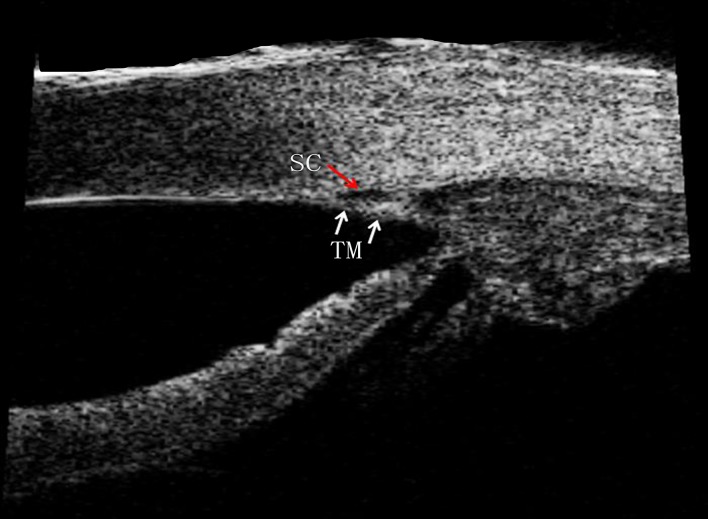
An 80-MHz Ultrasound Biomicroscopy Image of Schlemm’s Canal and the Trabecular Meshwork in a Normal Individual.Schlemm’s canal (red arrow) and the trabecular (white arrow) are apparent in the image.